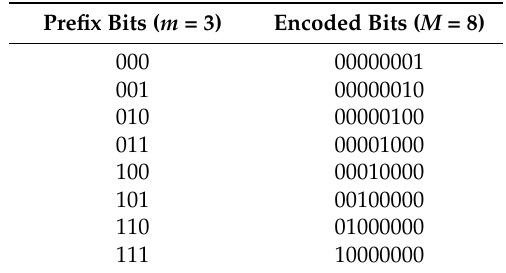
Table 4. m-M code ( m = 3).